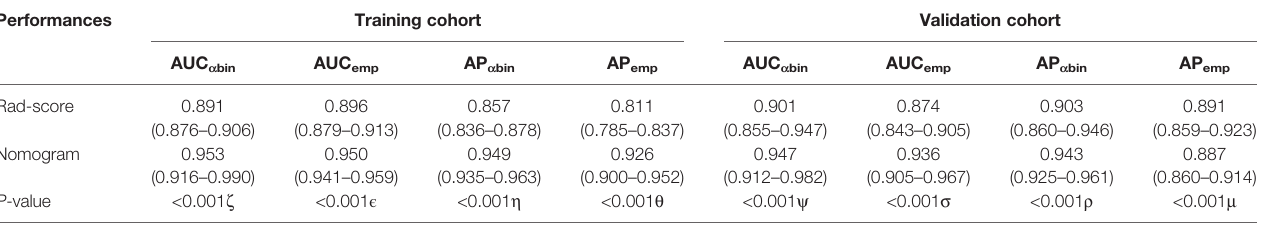
TABLE 2 | Comparison of the performances of Rad-score and nomogram.